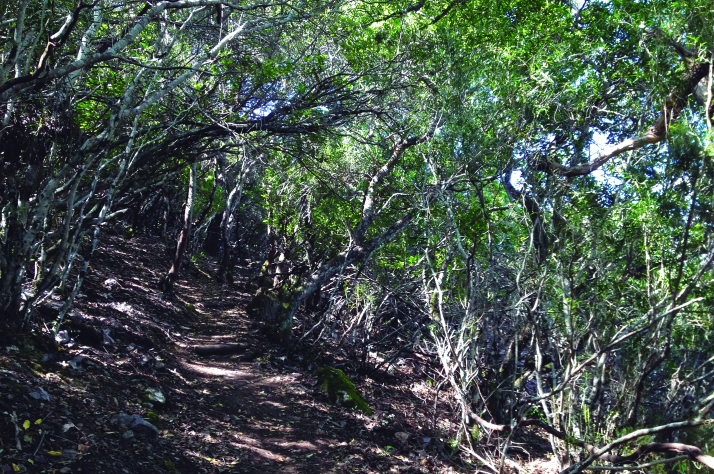
M2 plot Fuente del Frances, Quercus
faginea forest